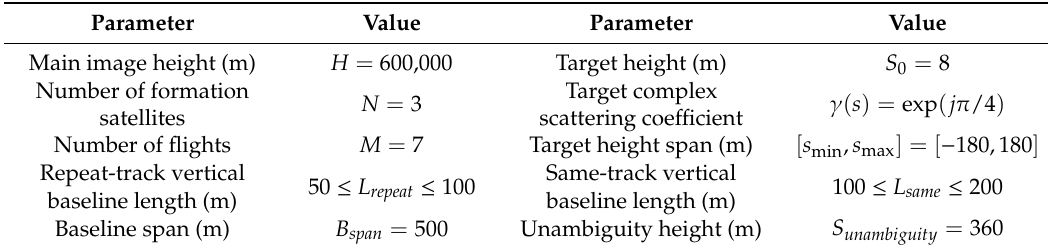
Table 1. Simulation